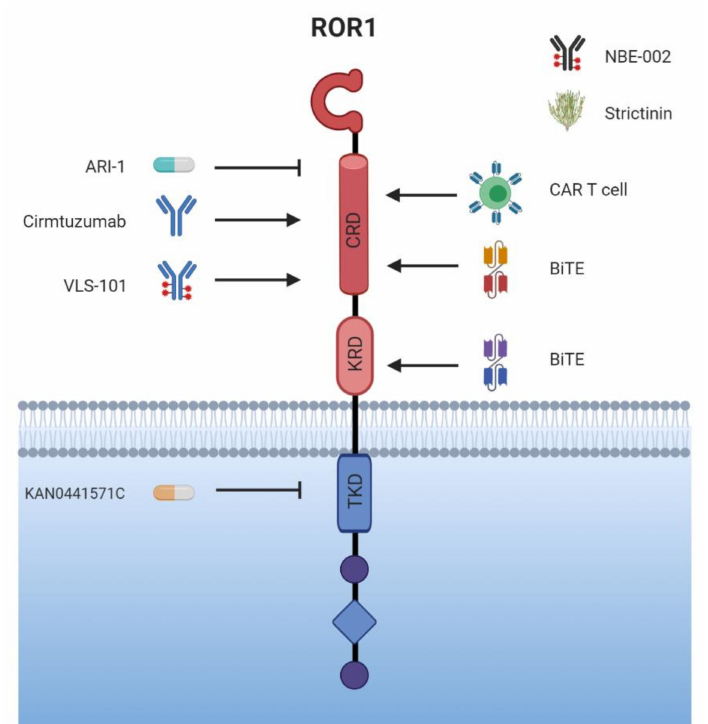
Figure 4. Targeting ROR1 with small molecules and immunotherapy—a selection of agents. While KAN0441571C functions as a tyrosine kinase inhibitor and already meets clinical evaluation, the inhibitor ARI-1, binding to the CRD of ROR1, is still in preclinical development. The most advanced monoclonal antibody (mAb) targeting ROR1 is cirmtuzumab. Other antibody-based targeting options comprise VLS-101, an antibody drug conjugate linking cirmtuzumab to MMAE, or bispecific antibodies such as ROR1 × CD3 or NBE-002. ROR1 is also an attractive target for chimeric antigen receptor- engineered (CAR) T cells since it does not lead to B cell depletion. Strictinin is a newly discovered, plant-derived tannin, which seemingly interacts with ROR1 and inhibits PI3K/AKT/GSK-3